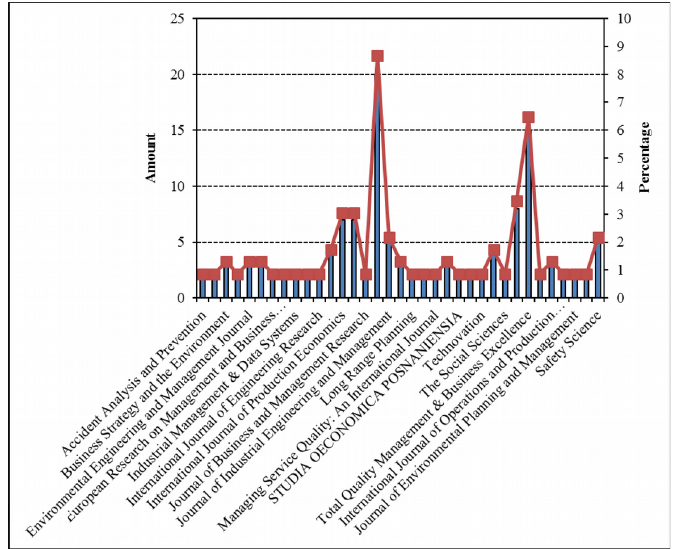
Figure 4. Distribution of the Nº of articles per journals with at